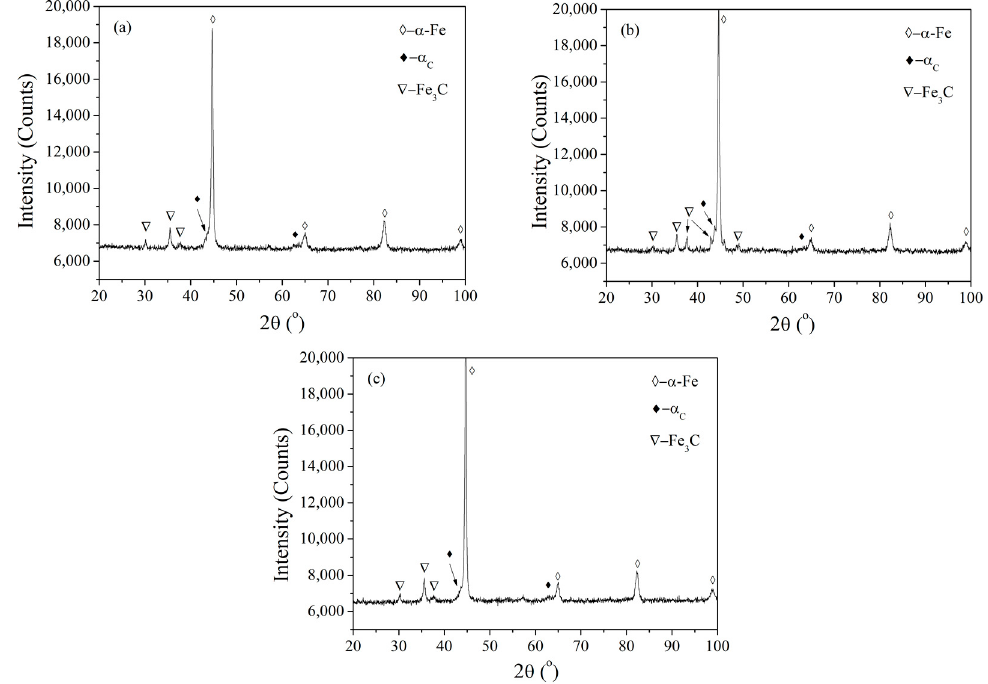
Figure 1. XRD patterns of AISI 420 stainless steel plasma carburized at 460 °C: ( a ) 4 h; ( b ) 8 h; and ( c ) 12 h.